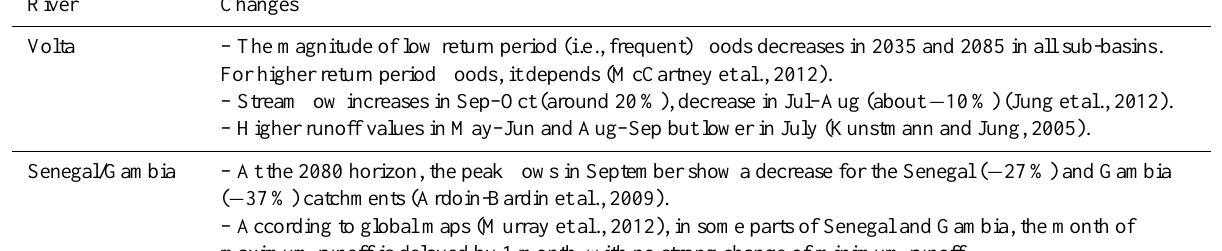
Table 4. Impact of future climate on monthly runoff and on floods/droughts, according to the papers selected in the database.